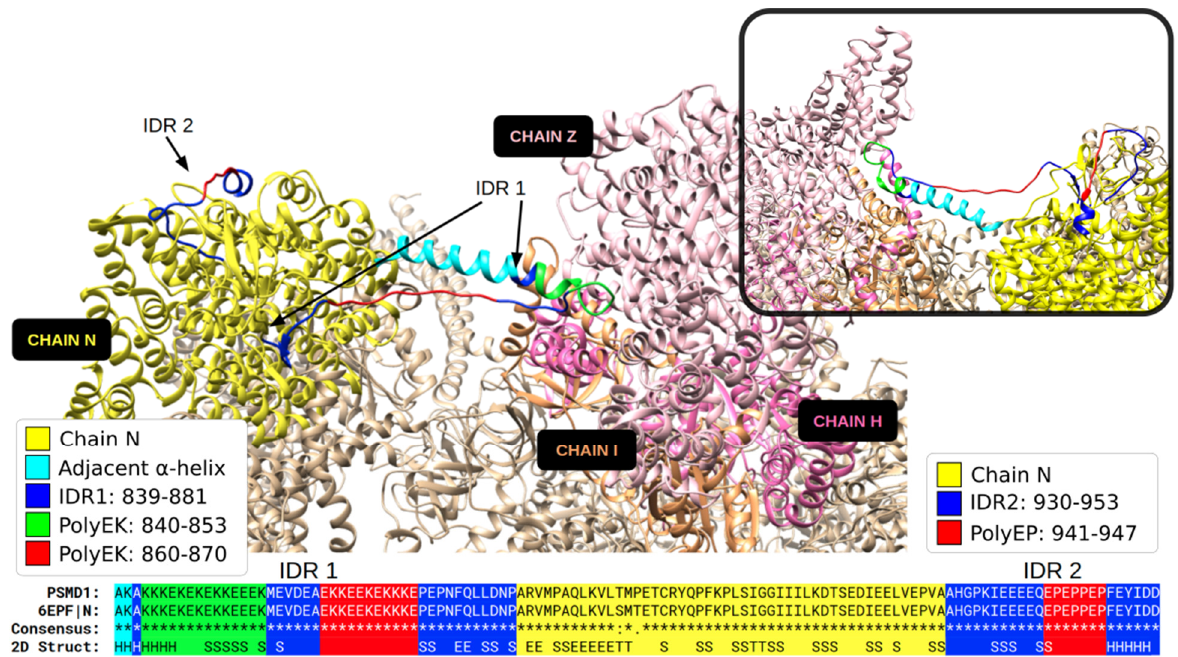
Figure 6. Two partially structured IDRs in the 26S proteasome non-ATPase regulatory subunit 1 . The human PSDM1 (UniProt: Q99460) aligns to the ortholog in rat (UniProt: O88761). The structure of the sequence from rat (PDB:6EPF chain N) includes one IDR (IDR1) with two polyEK and one IDR (IDR2) with a polyEP. The chains I, H and Z, with which IDR1 interacts, are highlighted. The inset in the upper-right corner shows the rotated superior angle of the structure, focusing on these interactions.